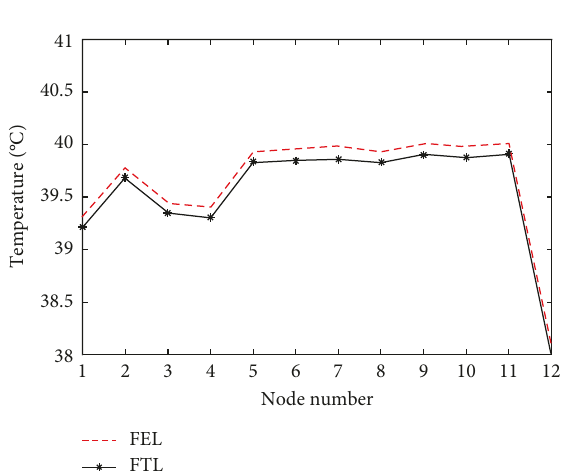
Figure 6: Return water temperature of each